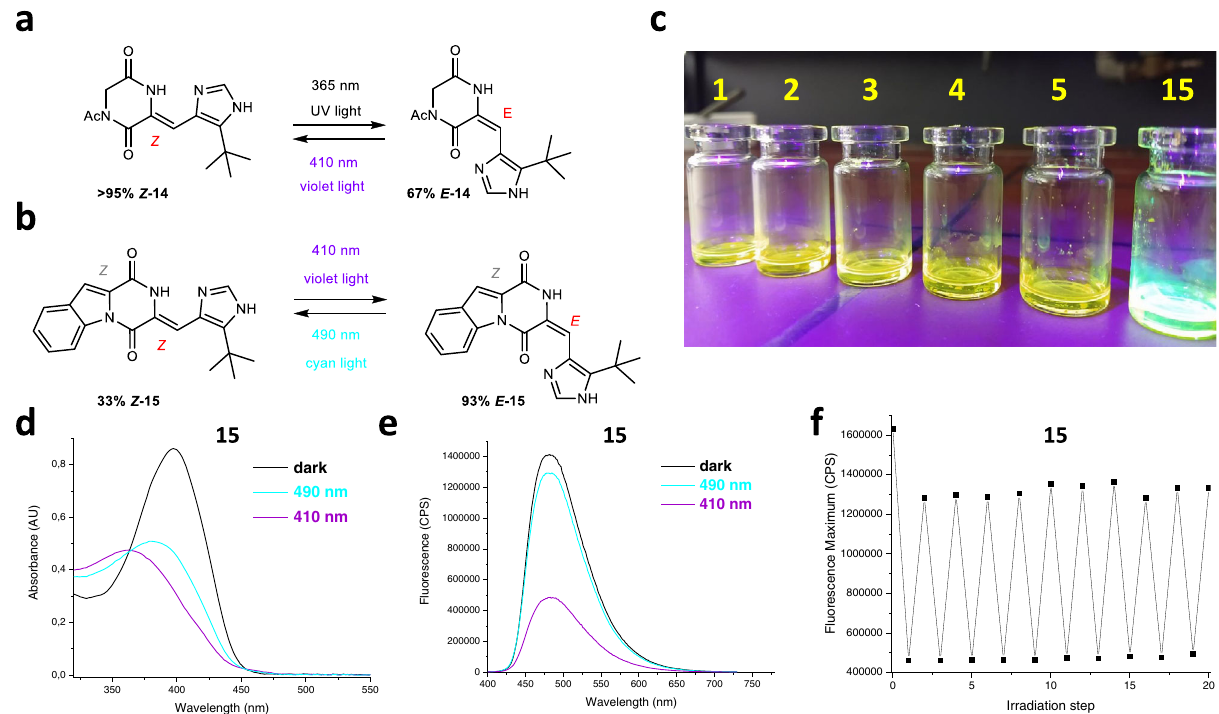
Fig. 6 | Further developments of photochromism in the plinabulin system. a Theisolatedheteroarylidenefragment 14 oftheoriginalplinabulin 1 structurecan be mutually photoisomerized with UV and violet light, although the same chro- mophoreremainsinerttowardsphotoisomerization withinthe completestructure of 1 . b Uponstabilizationofthecarbocyclicarylideneinthe Z- con fi gurationwithan additional bond, the resulting locked plinabulin 15 shows photoisomerization of the heteroarylidene C=C bond. c The locked system 15 additionally shows hypso- chromic shift and enhanced quantum yield of light emission in comparison to